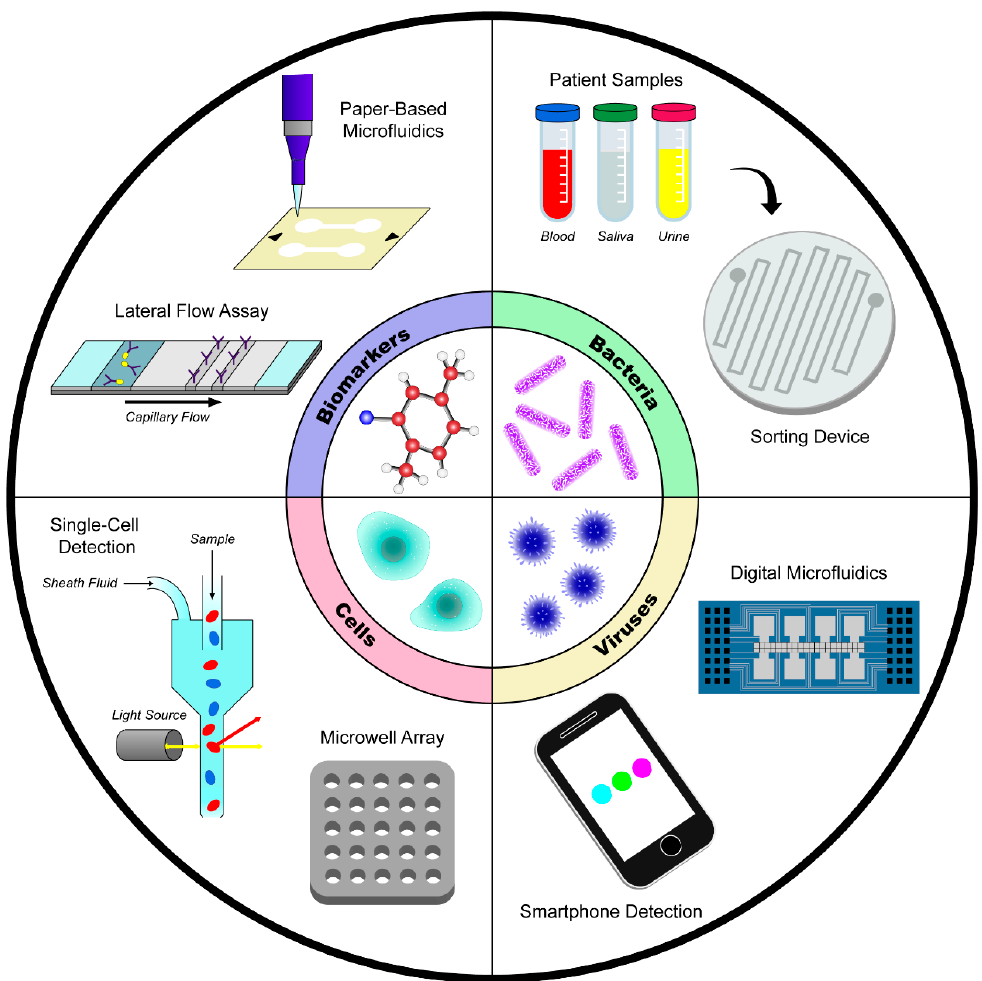
Figure 1. Microfluidic devices for biomarker, human cell, bacteria, and virus detection. Each panel contains some representative devices reviewed within this section.